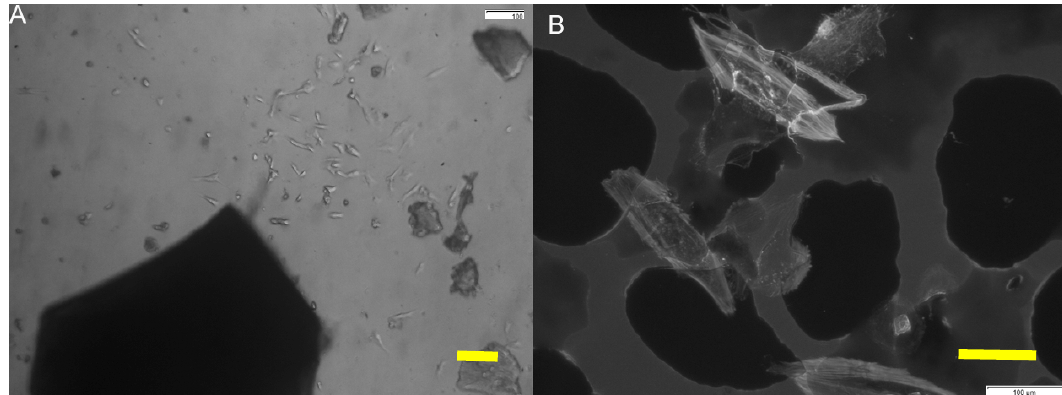
Figure 10. HOB ® osteoblasts grown on SCS8 sample after 24 h in culture ( A ) and examined with a